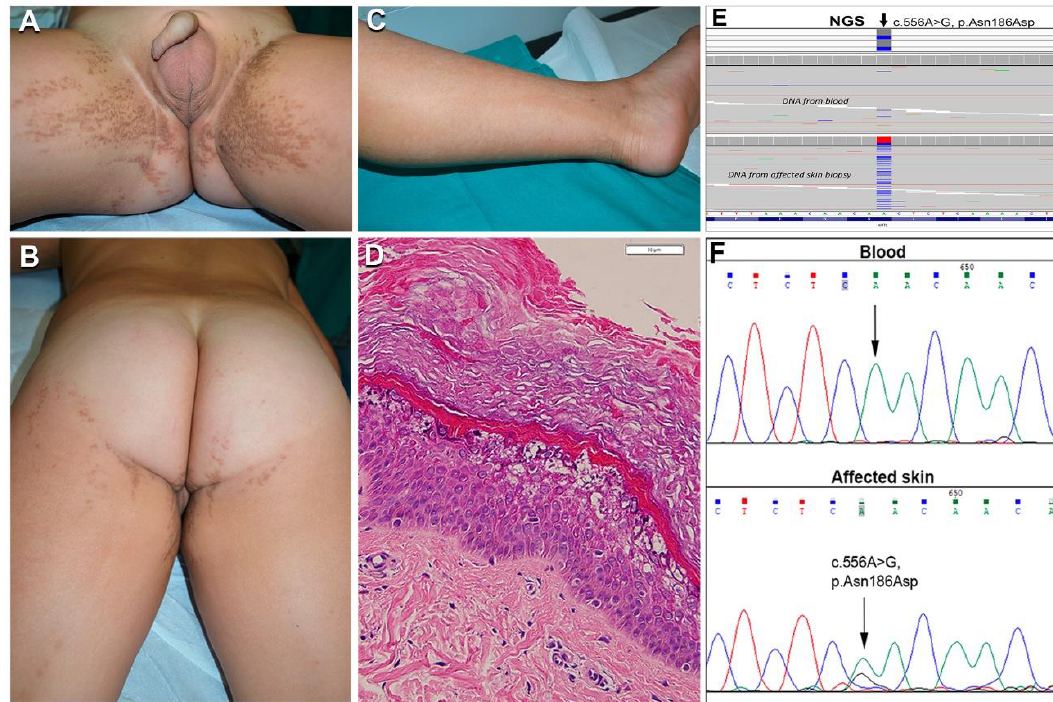
Figure 4. Clinical, histopathological, and molecular genetic findings in the first case of epidermolytic nevus (EN) due to KRT2 somatic mutation. Extensive bilateral brownish hyperkeratosis and hypopigmentation, both following Blaschko lines, on the inguinal folds, gluteal and perineal regions, thighs, and left leg ( A – C ) in a boy aged 3 years ( n . 26 of Table 1). Histopathology of a hypopigmented lesion shows vacuolar degeneration of suprabasal epidermal layers with irregular keratohyalin granules and eosinophilic cytoplasmic inclusions, in addition to hyperkeratosis ( D ); bar: 50 µm; similar findings accompanied by acanthosis and thicker hyperkeratosis were present in hyperkeratotic lesions (not shown). Mutant alleles with the KRT2 c.556A > G somatic mutation were detected by NGS sequencing both in DNA from blood (estimated frequency 1.5%) and affected skin (25%) ( E ). Sanger sequencing failed to detect the mutation in blood DNA but confirmed it in the DNA from affected skin, as demonstrated by the lower peak of nucleotide G under the wild-type A ( F ).